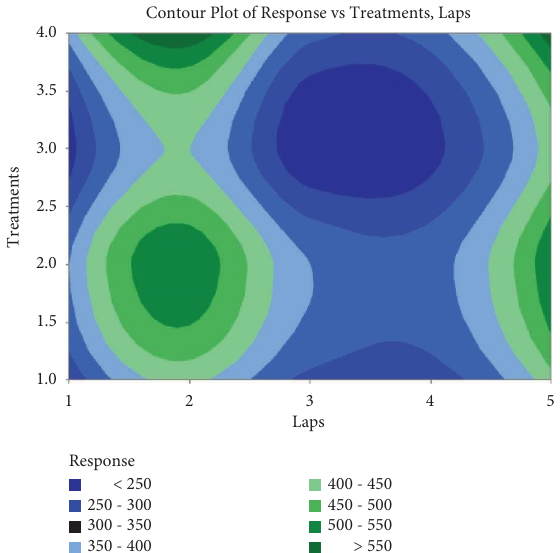
Figure 7: Contour plot of response vs. treatments vs. labs. Surface Plot of Response vs Treatments, Laps